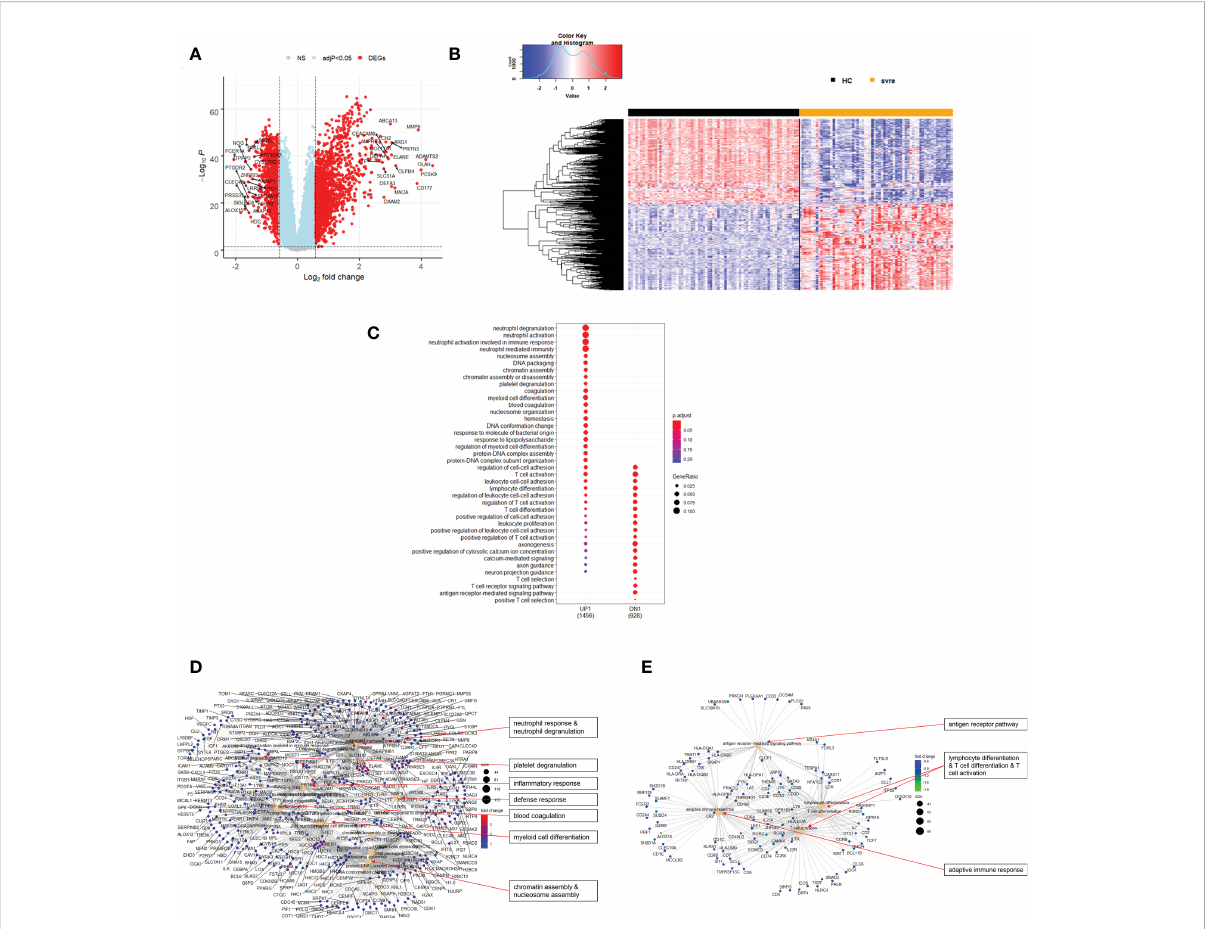
FIGURE 7 Differential genes expression analysis contrasting severe cases to healthy controls. (A) Volcano plot of results of the contrast from the linear regression analysis. y-axis: -log 10 BH multiple testing adjusted p-values, x-axis: log 2 fold change. DEGs (absolute log-fold change > 1.5, corresponding to a log 2 -fold change > 0.58; multiple testing adjusted p-value < 0.05) are colored red and the top 20 up- and down-regulated (by log-fold change) DEGs are labeled. Blue: genes with adjusted p-value < 0.05. (B) Heatmap of expression levels of top 500 (by log fold change) regulated DEGs. Values were scaled by row. red: up-regulated DEGs, blue: down-regulated DEGS. HC: healthy controls, mld/mod: mild/moderate pateints. (C) Functional analysis using GO term enrichment for up- and down-regulated DEGs showing 20 most signi fi cant pathway annotations for both groups. (D) cnetplot illustrating relationship of up-regulated DEGs to pathway annotations. (E) cnetplot illustrating relationship of down-regulated DEGs to pathway annotations. Nodes in cnetplots represent pathways signi fi cantly associated with the differentially expressed genes. The differentially expressed genes are connected to these nodes with color-coded log-fold changes with color- coded log-fold changes from the contrast between severe cases versus healthy controls. Abbreviations: HC stands for healthy controls; svre stands for